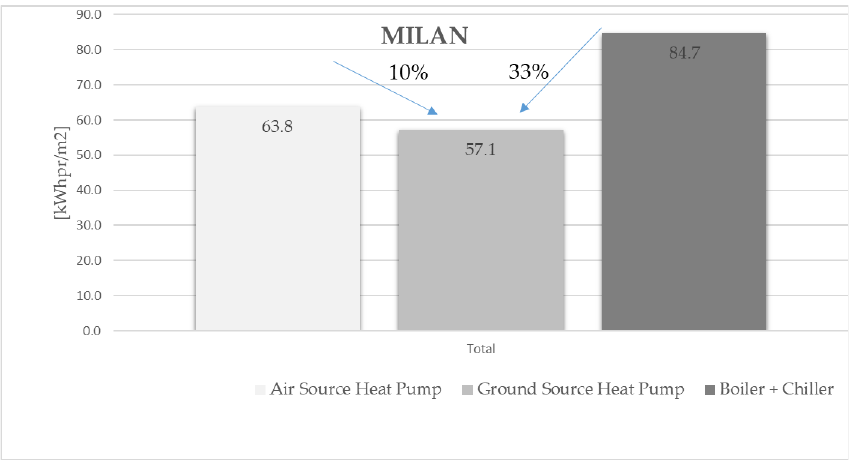
Figure 8. Entire yearly demand of primary energy (kWh / m 2 y) for the three analysed solutions in the case of Milan.